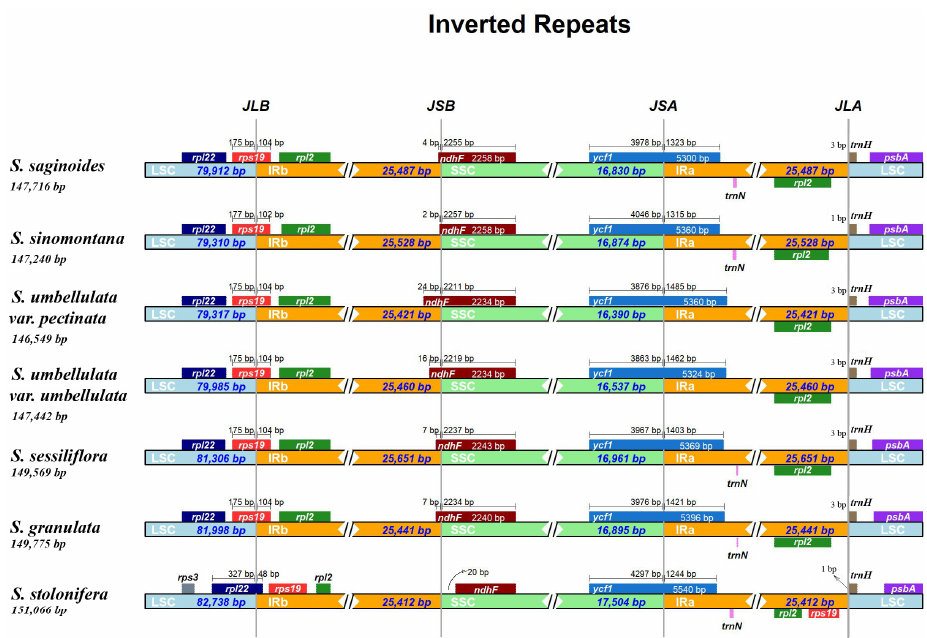
Figure 2. A plot displaying the boundaries of the LSC, SSC, and IR regions and genes around the junction sites for each Saxifraga cp genome. JLB, JSB, JSA, and JLA denote the junction sites of LSC and IRb, IRb and SSC, SSC and IRa, and IRa and LSC,